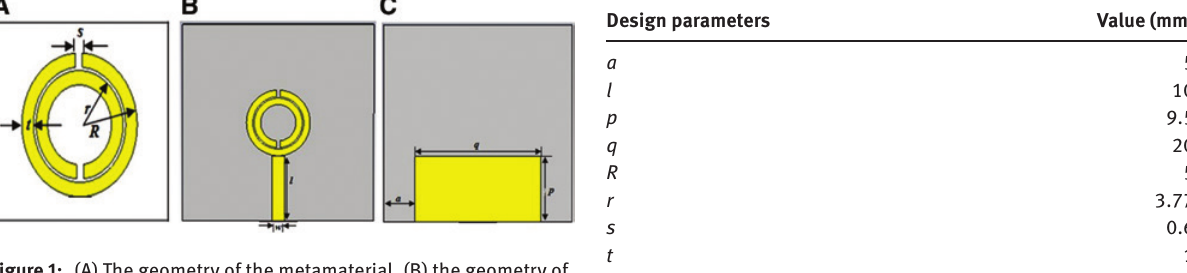
Figure 1: (A) The geometry of the metamaterial, (B) the geometry of the antenna (front view), (C) Rear view of the antenna.